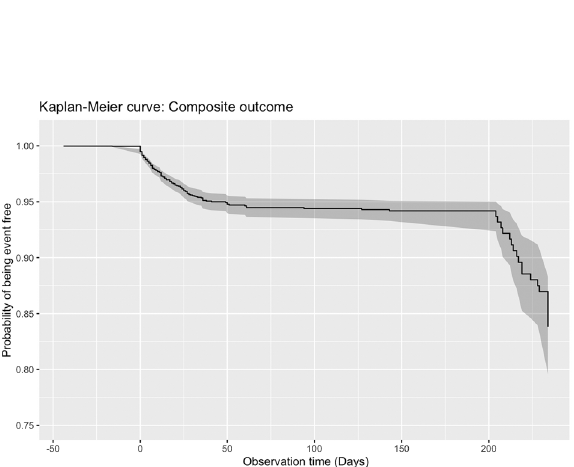
Fig. 1 Survival analysis for the cohort from Hong Kong, China. Survival curve of COVID-19 patients for the primary outcome, a composite of intensive care admission, need for intubation or